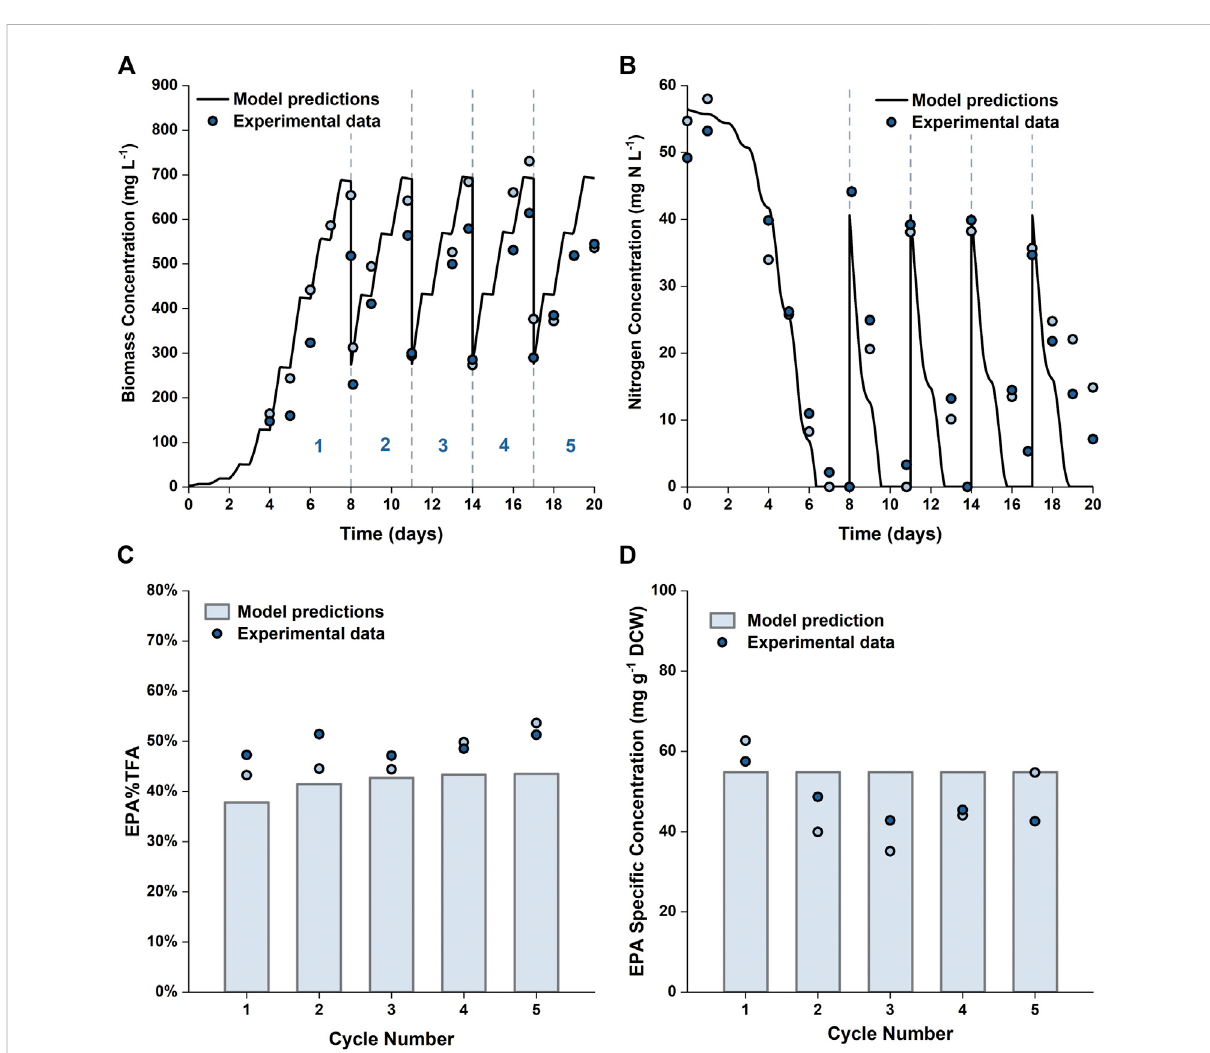
FIGURE 10 Comparisonbetweenexperimentallymeasuredandmodelpredictedbiomassconcentration (A) ,nitrogenconcentrationinthegrowthmedium (B) ,EPAfractionintotalfattyacids (C) andspeci fi cconcentrationofEPAinbiomass (D) inrepeated-batchculturesof P.tricornutum grownin5 L fl at- panel PBRs. The cultures were grown in batch mode in 5 × f /2 medium for 8 days, then every 3 days 60% of the culture broth was removed and replaced with 6 × f /2 medium. Scatter plots represent two biologically independent